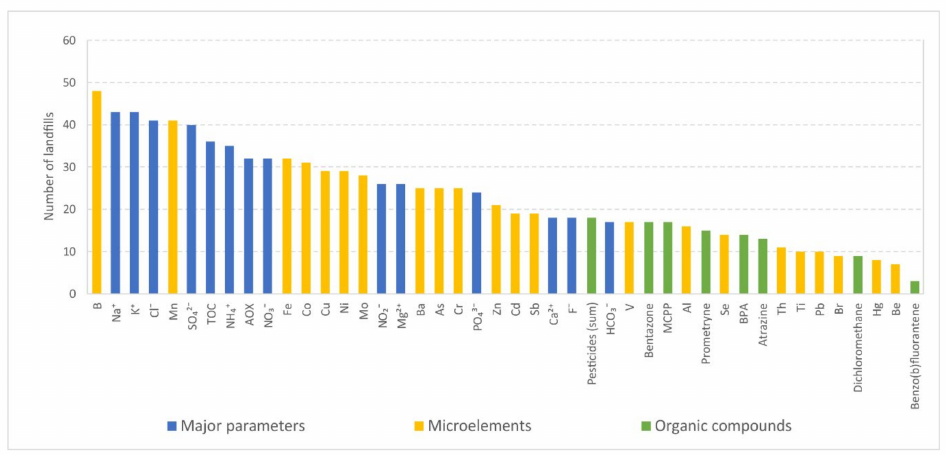
Figure 4. Frequencies of determined